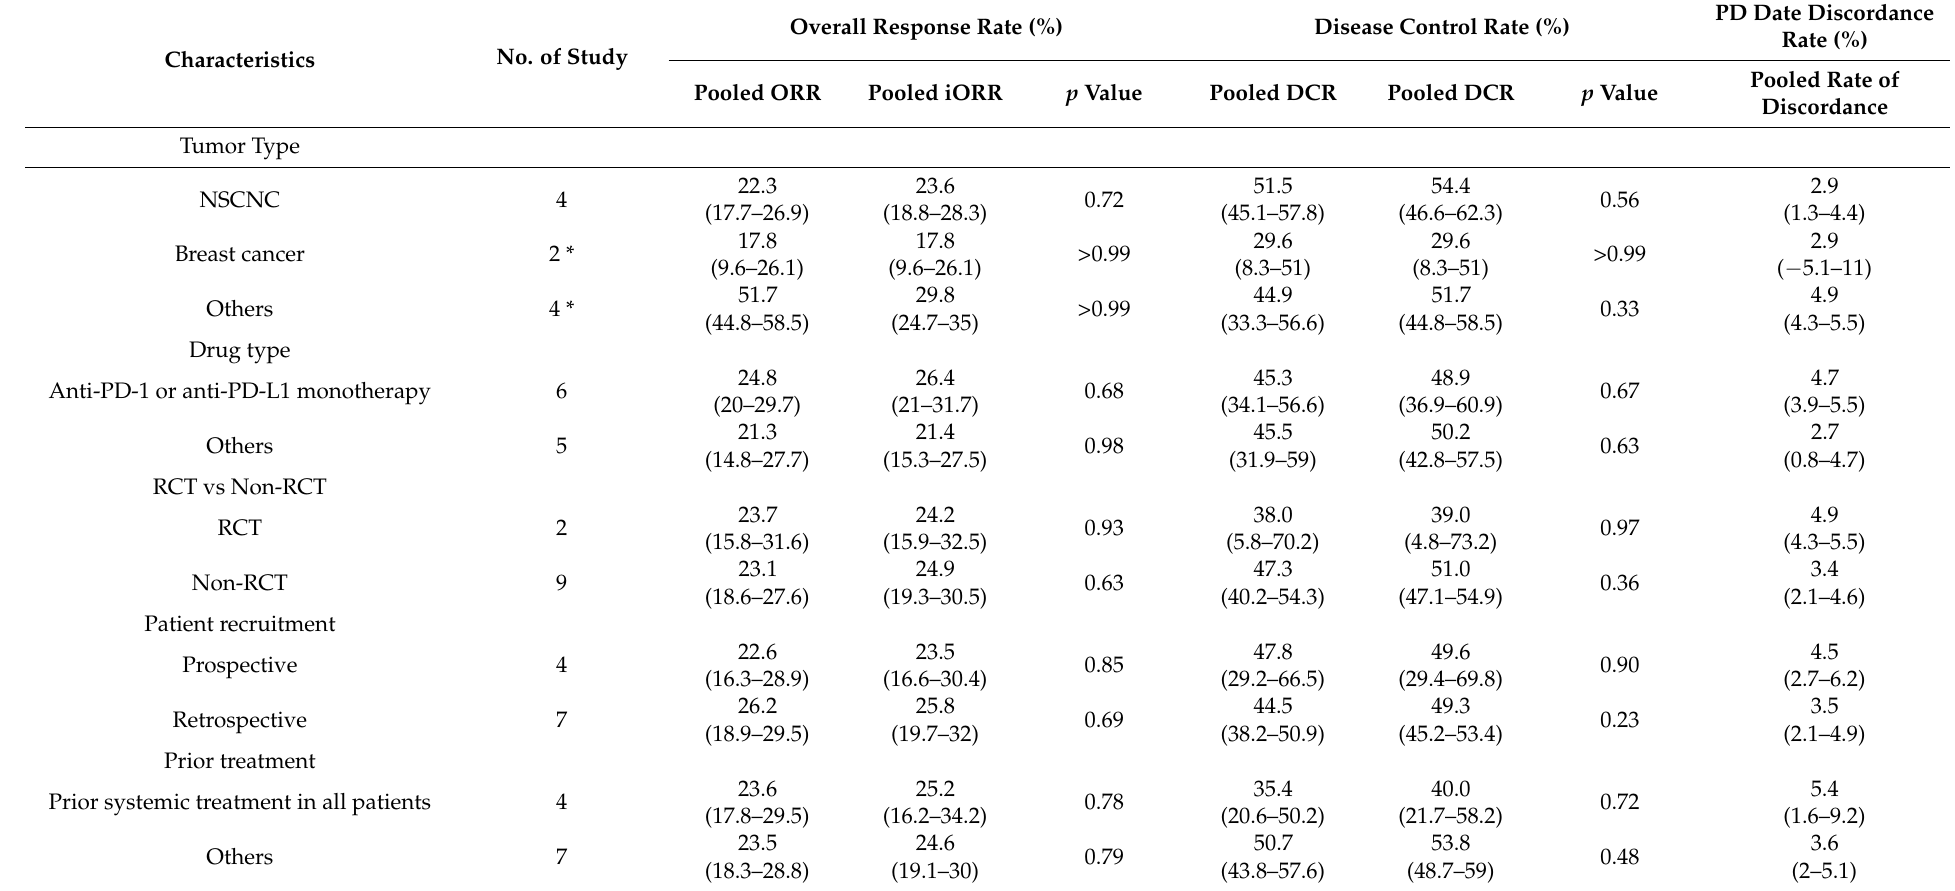
Table 2. Sensitivity analyses according to tumor type, drug type, study design, and prior